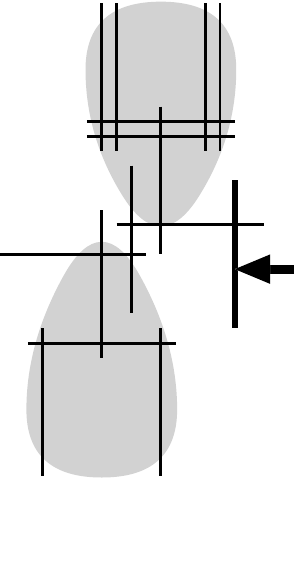
Figure 8. Hamiltonian path problem.